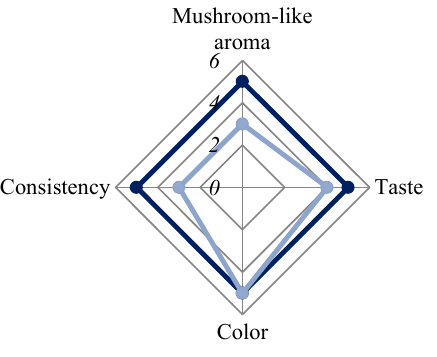
Figure 6 Sensory profilogram for fermented sauces based on Aspergillus oryzae AAS = М ∗ М R